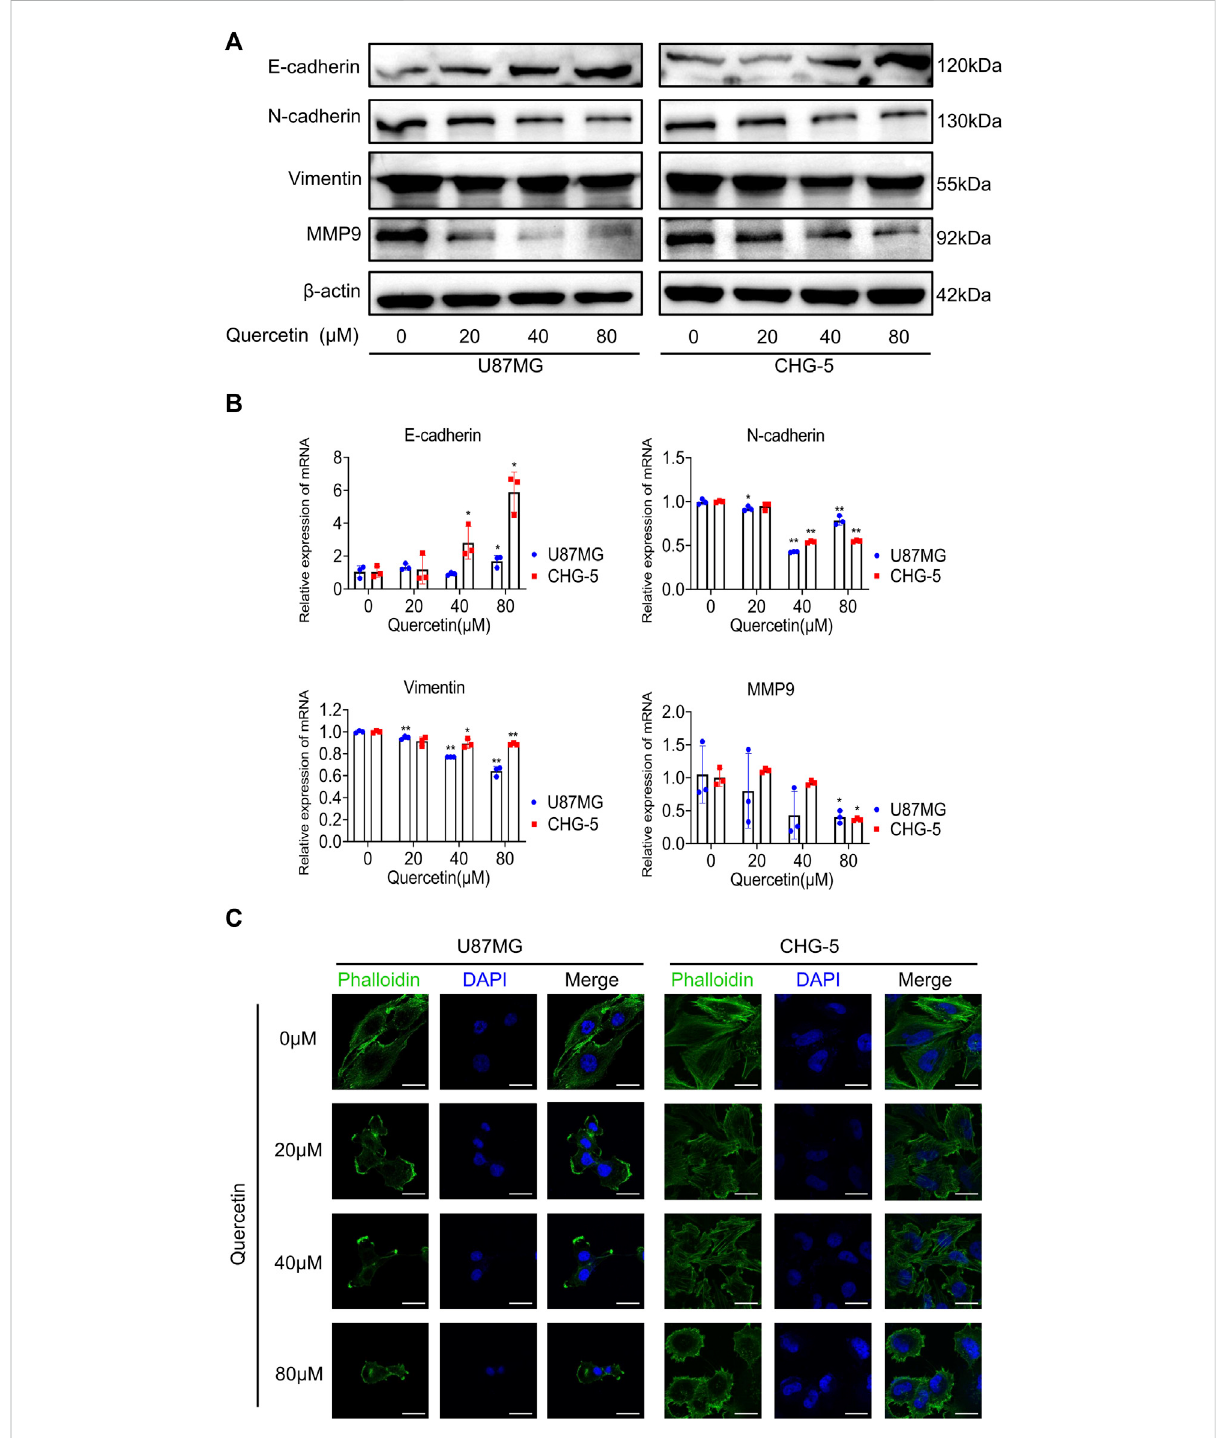
FIGURE 4 Quercetin suppresses the EMT-like programme in glioblastoma cells. (A) Western blotting was used to detect the expression of mesenchymal markers(N-cadherin,vimentin,andMMP-9)aftertreatmentwithquercetin(0,20,40,80 μ M)inU87MGandCHG-5celllines. (B) RT-qPCRanalysisof the mRNA levels of E-cadherin, N-cadherin, Vimentin, and MMP-9 after U87MG and CHG-5 cells were treated with quercetin (0, 20, 40, 80 μ M). All data areshown as themean ±SD ofthree experiments.* p ＜ 0.05, ** p ＜ 0.01 vs. control group. (C) Representative immuno fl uorescence images of the cytoskeleton (green) of U87MG and CHG-5 cells treated with quercetin (0, 20, 40, 80 μ M). Scale bar, 20 μ